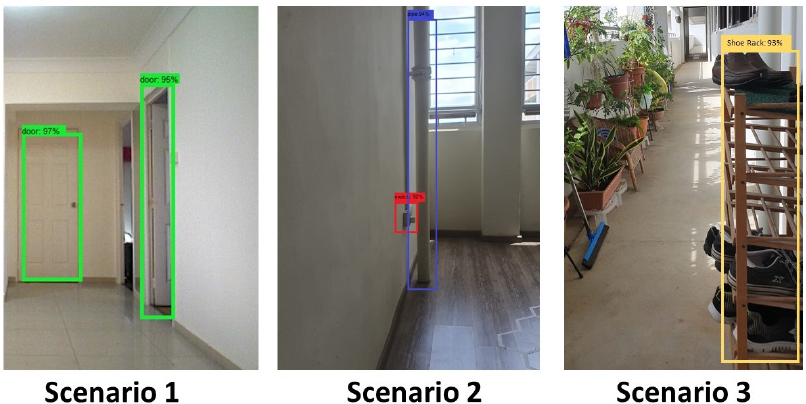
Figure 17. Wall/floor segmented result of scenario-1 ( left ), scenario-2 ( middle ), scenario-3 ( right ).